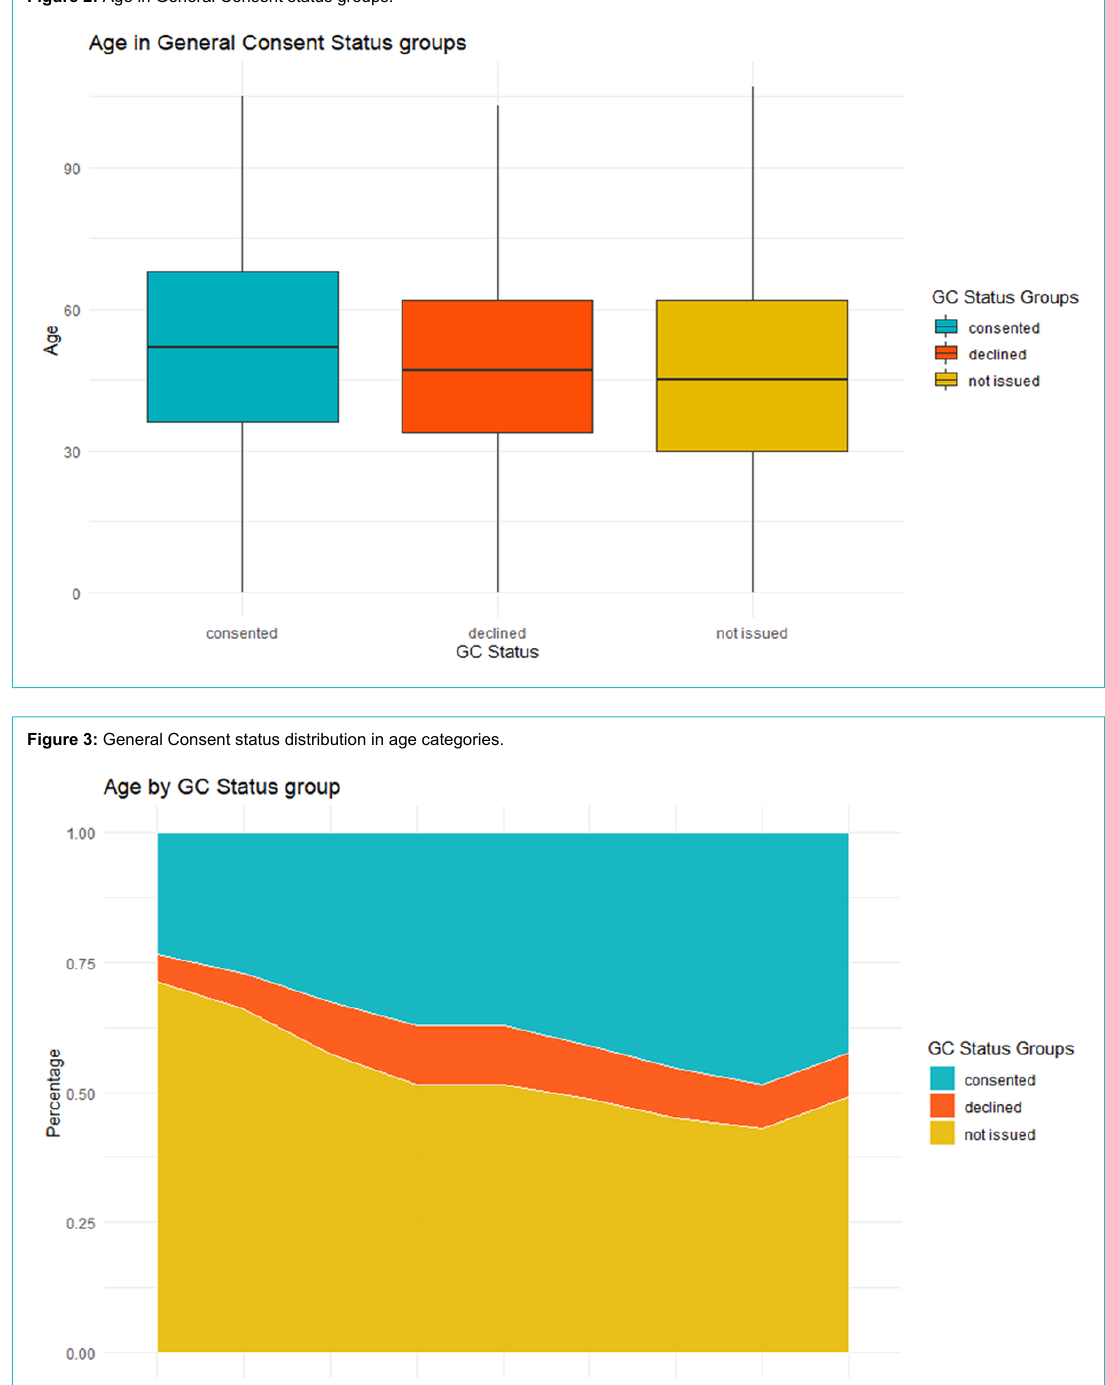
Figure 2: Age in General Consent status groups.